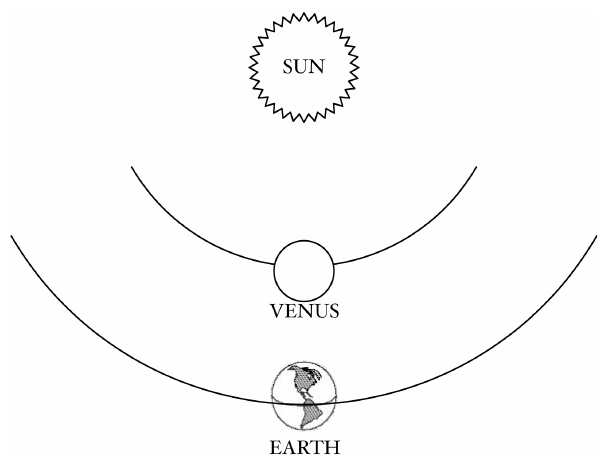
Fig. 2. Schematic representation of Venus-Sun inferior conjunction, that took place on 27 March